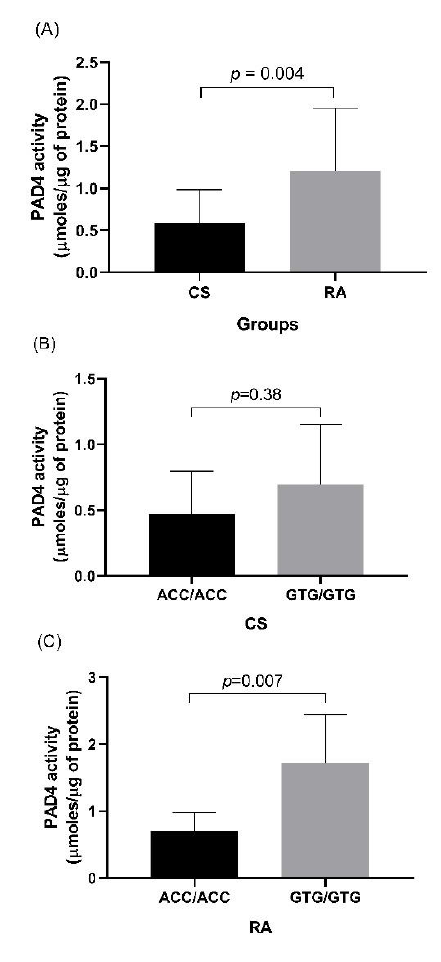
Figure 5. Determination of PAD4 activity in CS and RA patients. ( A ) Comparison of PAD4 activity in CS and RA carrying the ACC and GTG haplotypes. ( B ) Comparison of PAD4 activity in CS carrying the ACC and GTG haplotypes. ( C ) Comparison of PAD4 activity in RA patients carrying the ACC and GTG haplotypes. The p value was calculated by the Mann – Whitney U test, comparing the value of the slope obtained for each subject.